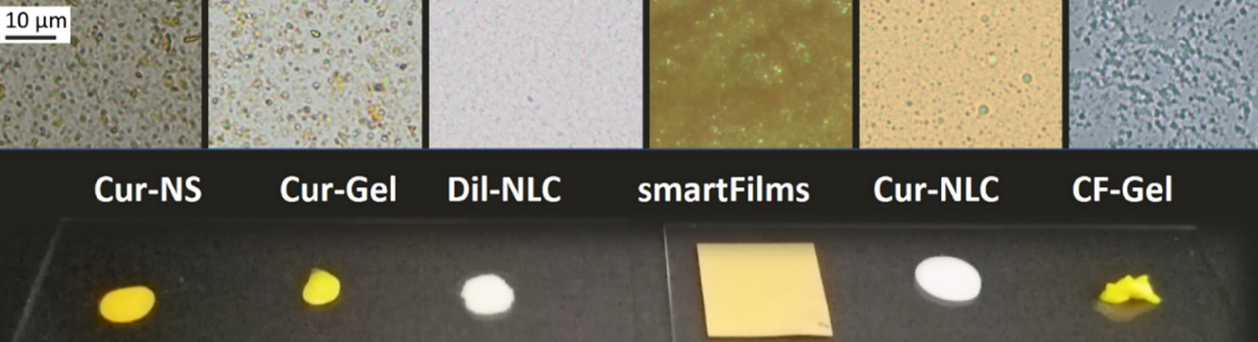
Figure 1. Microscopic images (upper: image sections of 1000-fold magnifications for Cur-NS, Cur-Gel, DiI-NLC, Cur-NLC and CF-Gel, and 50-fold magnification for smartFilms (scale bar corresponds to 5 mm) and macroscopic images (lower) of the formulations used in this study.